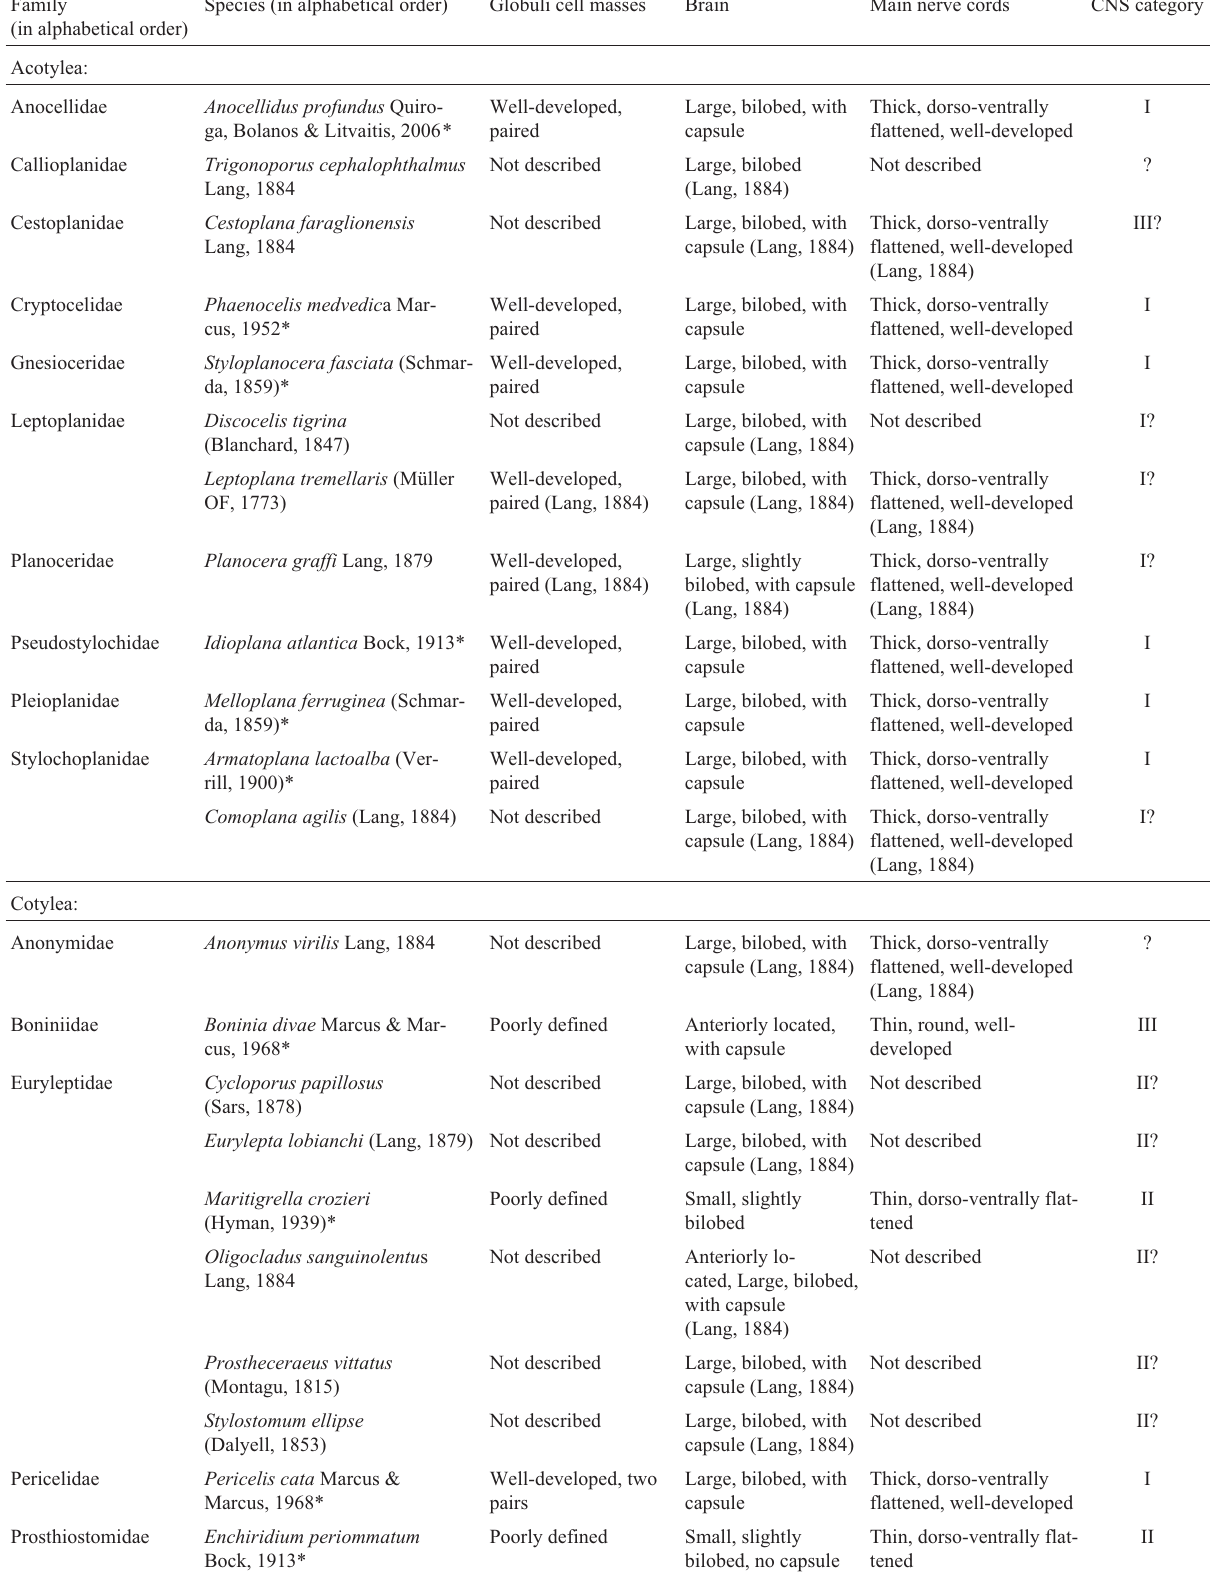
Table 1 - Comparison of the nervous system in polyclads Family Species (in alphabetical (in alphabetical order)